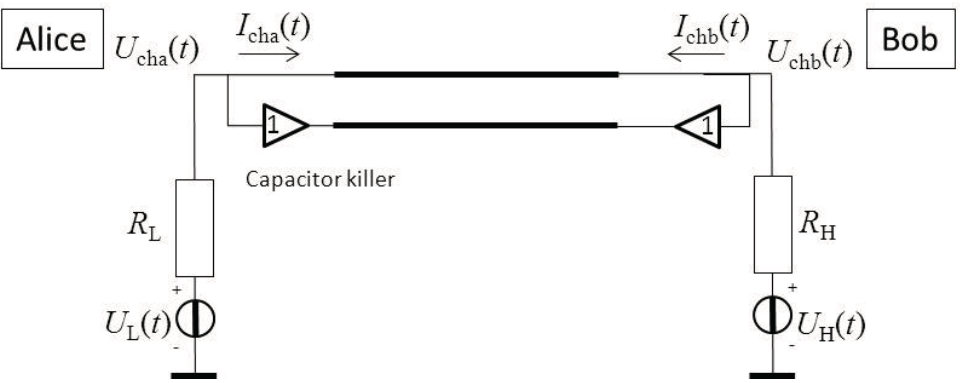
Figure 8. The KLJN system with the capacitor killer. An ideal voltage follower is driving the outer shield, which is not grounded at this